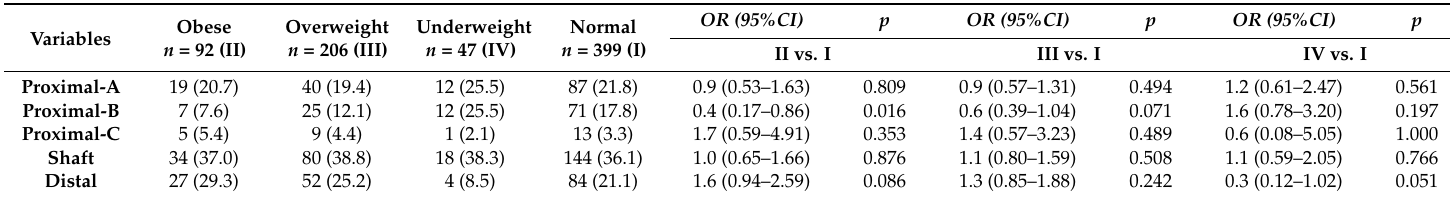
Table 4. Location of femoral fracture in patients with different weight classes in motorcycle